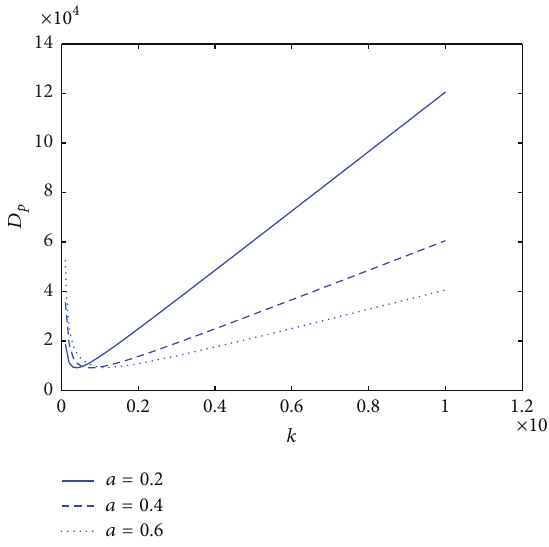
Figure 3: Damping time 𝜏 𝑑 versus wavenumber k .